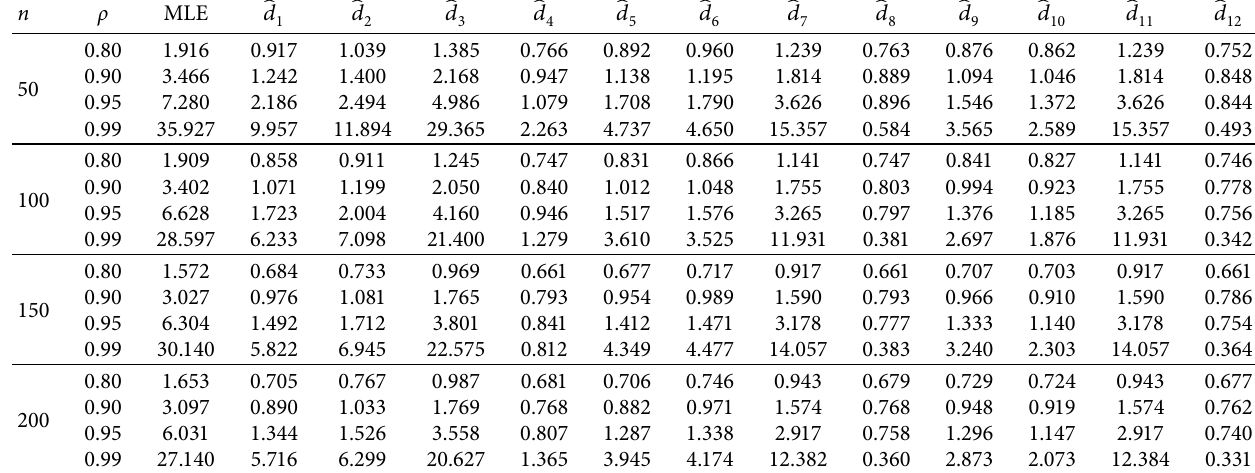
Table 1: Estimated MSEs of the COMPRM estimators, when p � 3 and ϑ � 0 . 85.